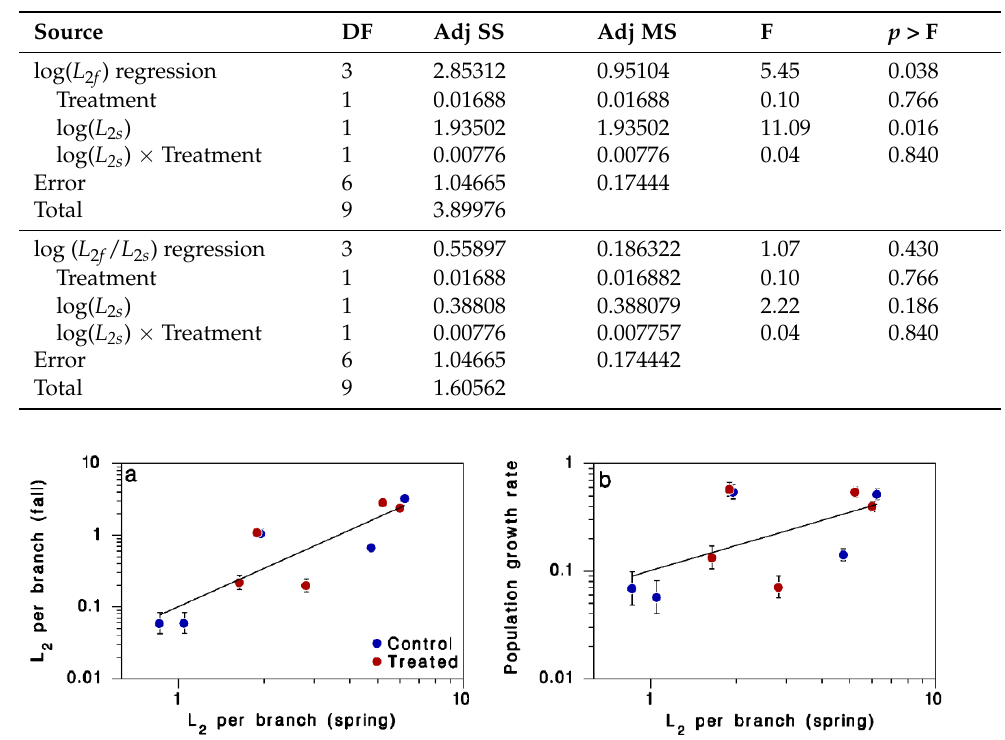
Figure 7. Relationship between spring L 2 density and ( a ) fall L 2 density or ( b ) population growth rate (from L 2 s to L 2 f ). Means ± SEM; blue: control blocks; red: treated blocks. Line in ( a ) is Equation (2). Line in ( b ) has slope 0.755 ± 0.385, but this relationship did not reach significance (α = 0.05).